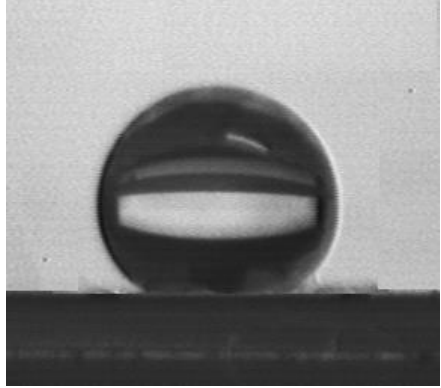
Figure 10. Silicon wafer treated with FSi@SiO 2 in dipping method, WCA = 150.3 °.